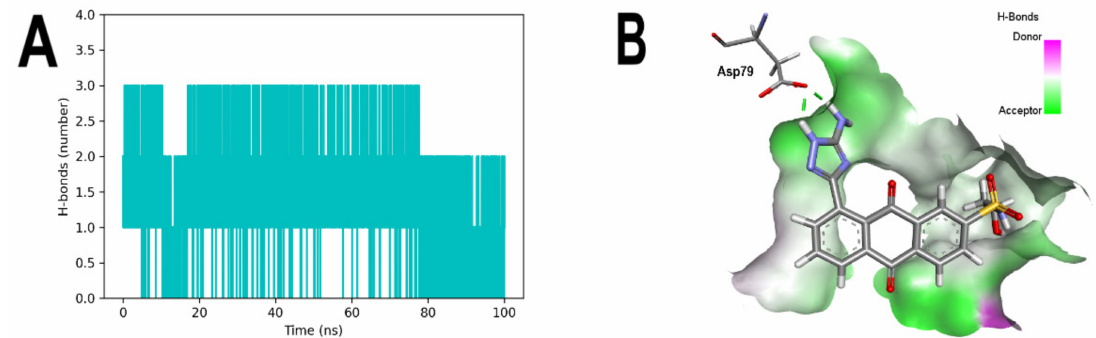
Figure 8. MDS analyses of 3ZKBL complexed to ATD. ( A ) Hydrogen bonds between Asp79 and ATD in the 3ZKBL-ATD complex. ( B ) Snapshot at 100 ns of 3ZKBL-ATD complex highlighting the hydrogen bonds of ATD with Asp79. The hydrogen bond analysis was performed with GROMACS. 3D hydrogen bond surface representation was performed with Discovery Studio